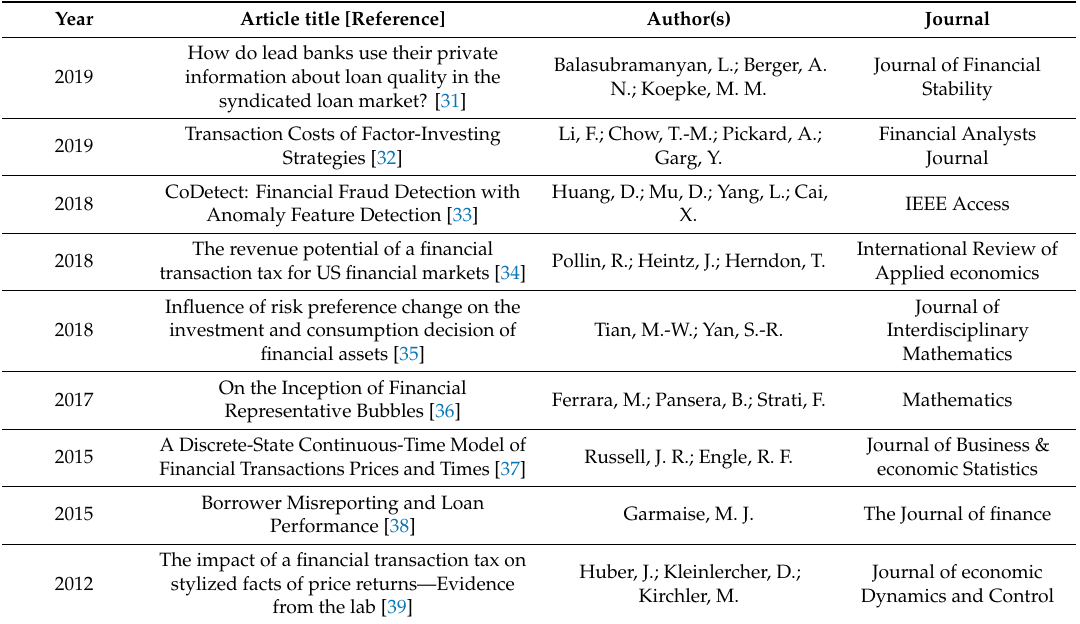
Table 1. Main articles reviewed related to the objective of